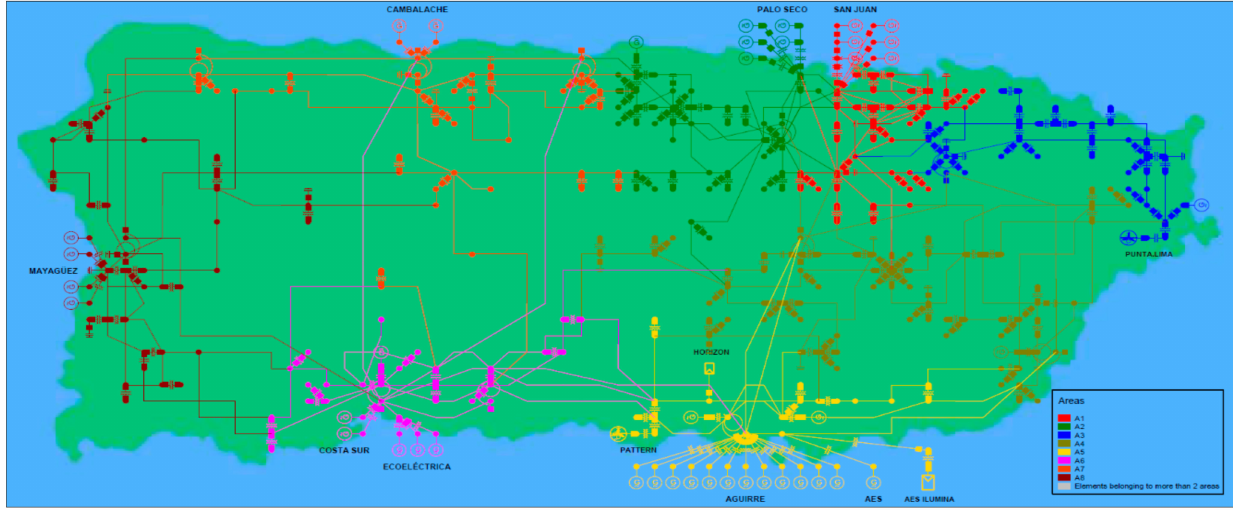
Figure 9. One-line diagram of the Puerto Rico electric power system divided by